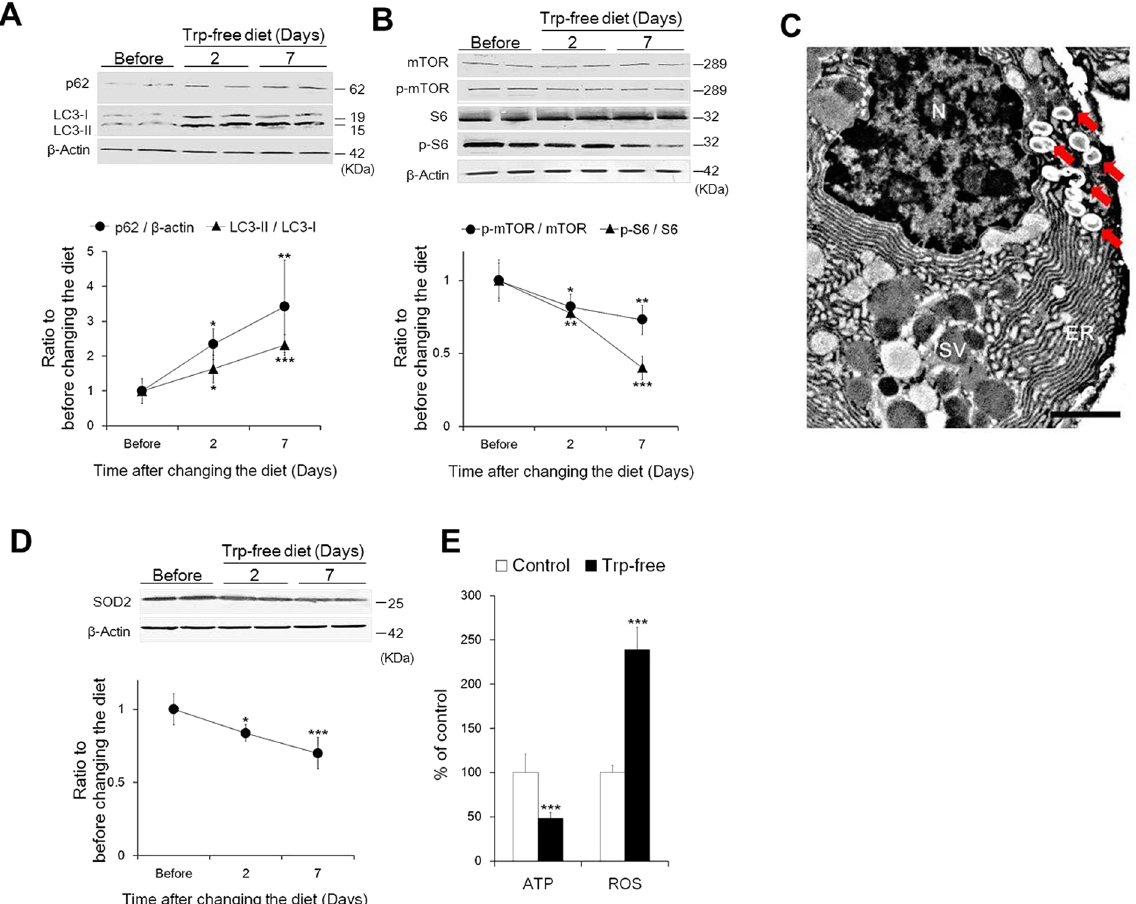
Figure 3. Lacrimal gland atrophy due to decrease in blood 5-HT concentration is induced by activation of autophagy. ( A ) Changes in expression levels of p62 and LC3-II in the LG. ( B ) Changes in the phosphorylation levels of mTOR and S6 in the LG. ( C ) The high magnification TEM image of autophagosomes (red arrows) found in LG acinar cells of the Trp-free diet group. Photograph from day 7 after changing to a Trp-free diet. The nucleus, secretory vesicles, and endoplasmic reticulum are shown as N, SV, and ER, respectively. ( D ) Changes in expression levels of SOD2 in the LG. Data ( A – D ) show the representative western blot images and quantitative analysis (line chart) before changing the diet, and 2 days and 7 days after changing to a Trp-free diet. Solid circles and triangles indicate the ratios of p62/ β -actin and LC3-II/LC3-I ( A ), and p-mTOR/mTOR and p-S6/S6 ( B ), respectively. ( E ) Alterations in ATP content and ROS generation in the LG at day 7 after changing to a Trp- free diet. Data show the percentage of the value in the Trp-free group relative to that in controls for ATP content and ROS generation. Open and solid columns show the control group and Trp-free group, respectively. All data represent the mean ± SD, n = 5 LGs. * P < 0.05, ** P < 0.01, *** P < 0.001 versus before ( A , B , D ), *** P < 0.001 versus control ( E